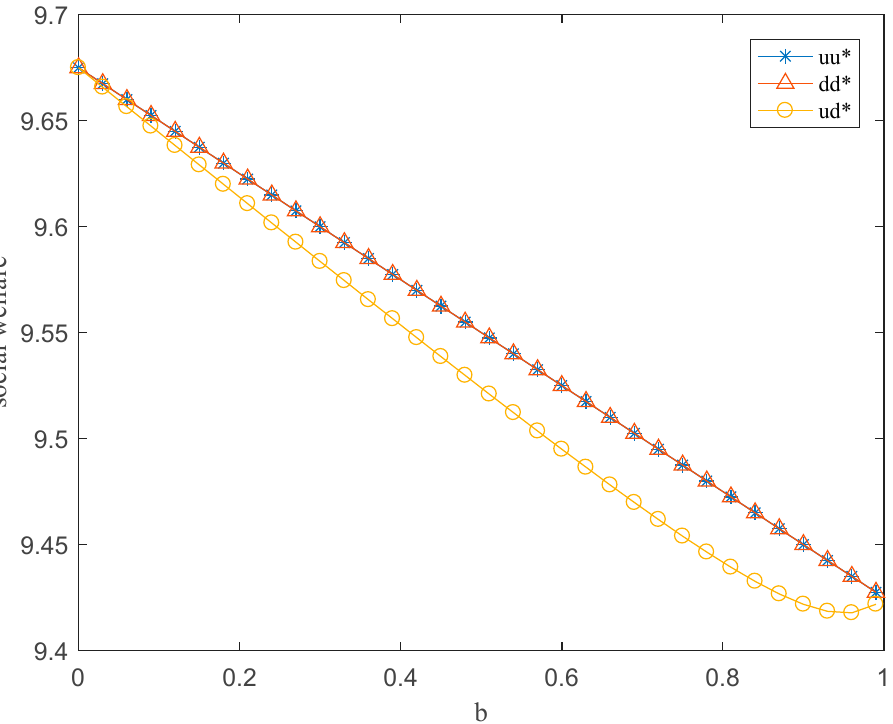
Figure 2. The total producer surplus under different situations.